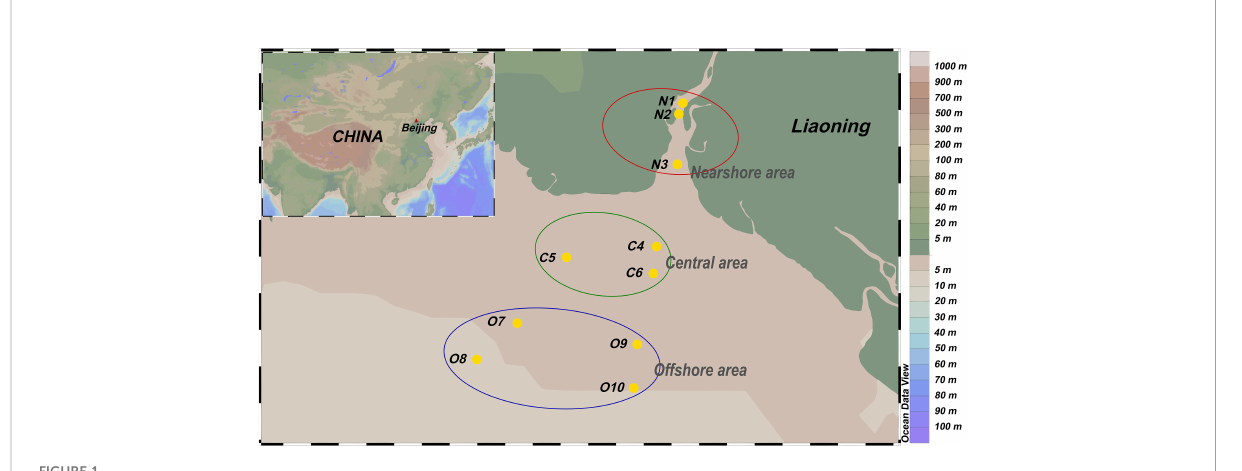
FIGURE 1 Sampling sites of seawater samples in Liaohe